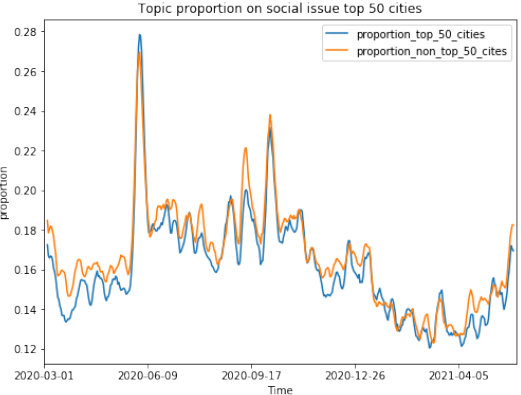
Figure 7. NPI topic proportions: top 50 cities vs. the rest of the country.